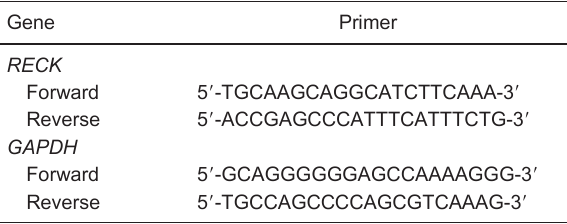
Table 2. Primer sequences for quantitative real-time